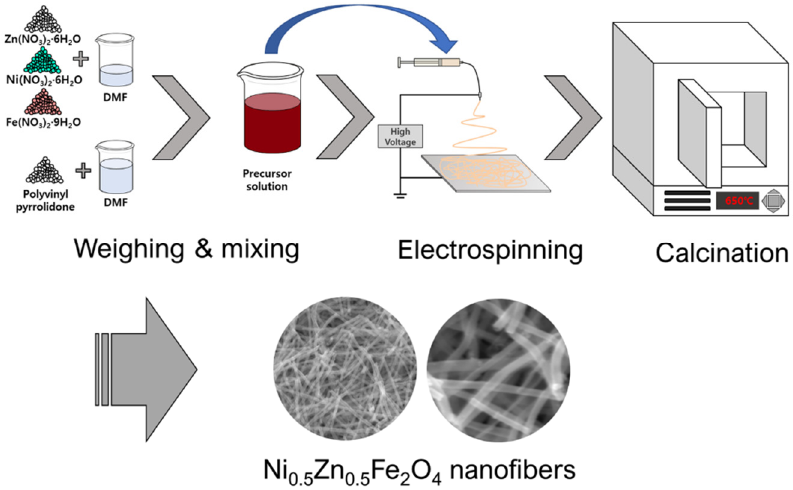
Figure 1. Schematic diagram of the fabrication process with electrospinning and